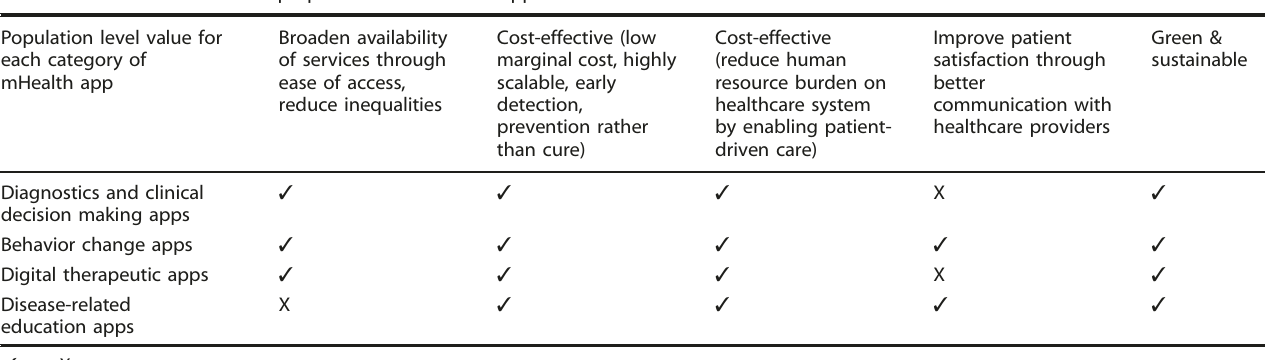
Table 3. Potential future value propositions for mHealth apps. Population level value for each category